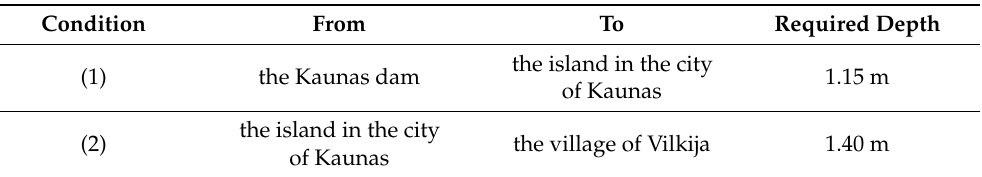
Table 2. Required depth along the entire reach under investigation. ( source: State Enterprise Lithuanian Inland Waterways Authority